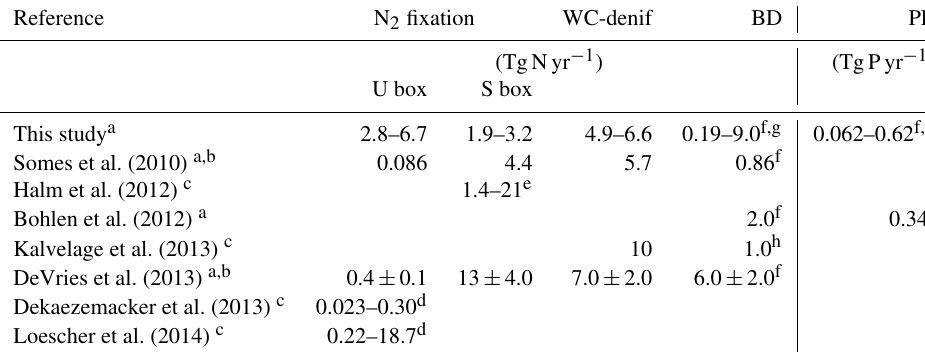
Table 3. Model flux comparison with model-based and observational